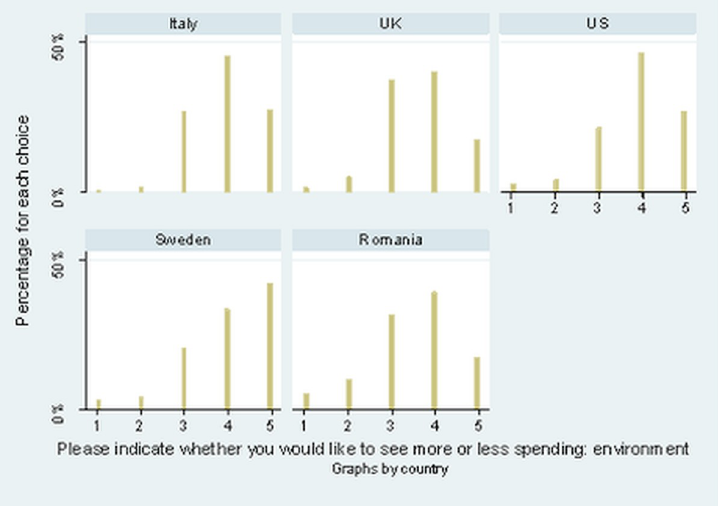
Fig 1. Preferences for more or less government spending on the environment. The five possible choices were: 5 = Spend much more; 4 = Spend more; 3 = Spend the same as now; 2 = Spend less; 1 = Spend much less. The